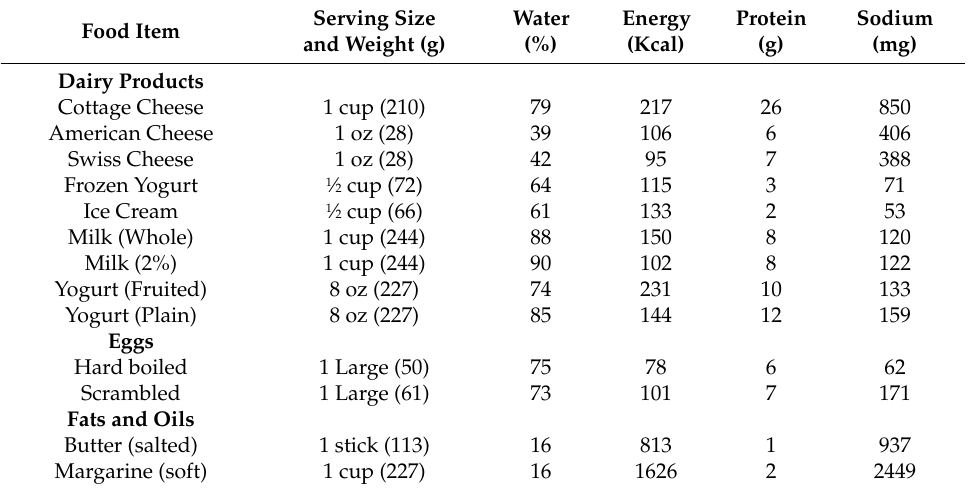
Table 5. Water, energy, protein and sodium contents of common foods